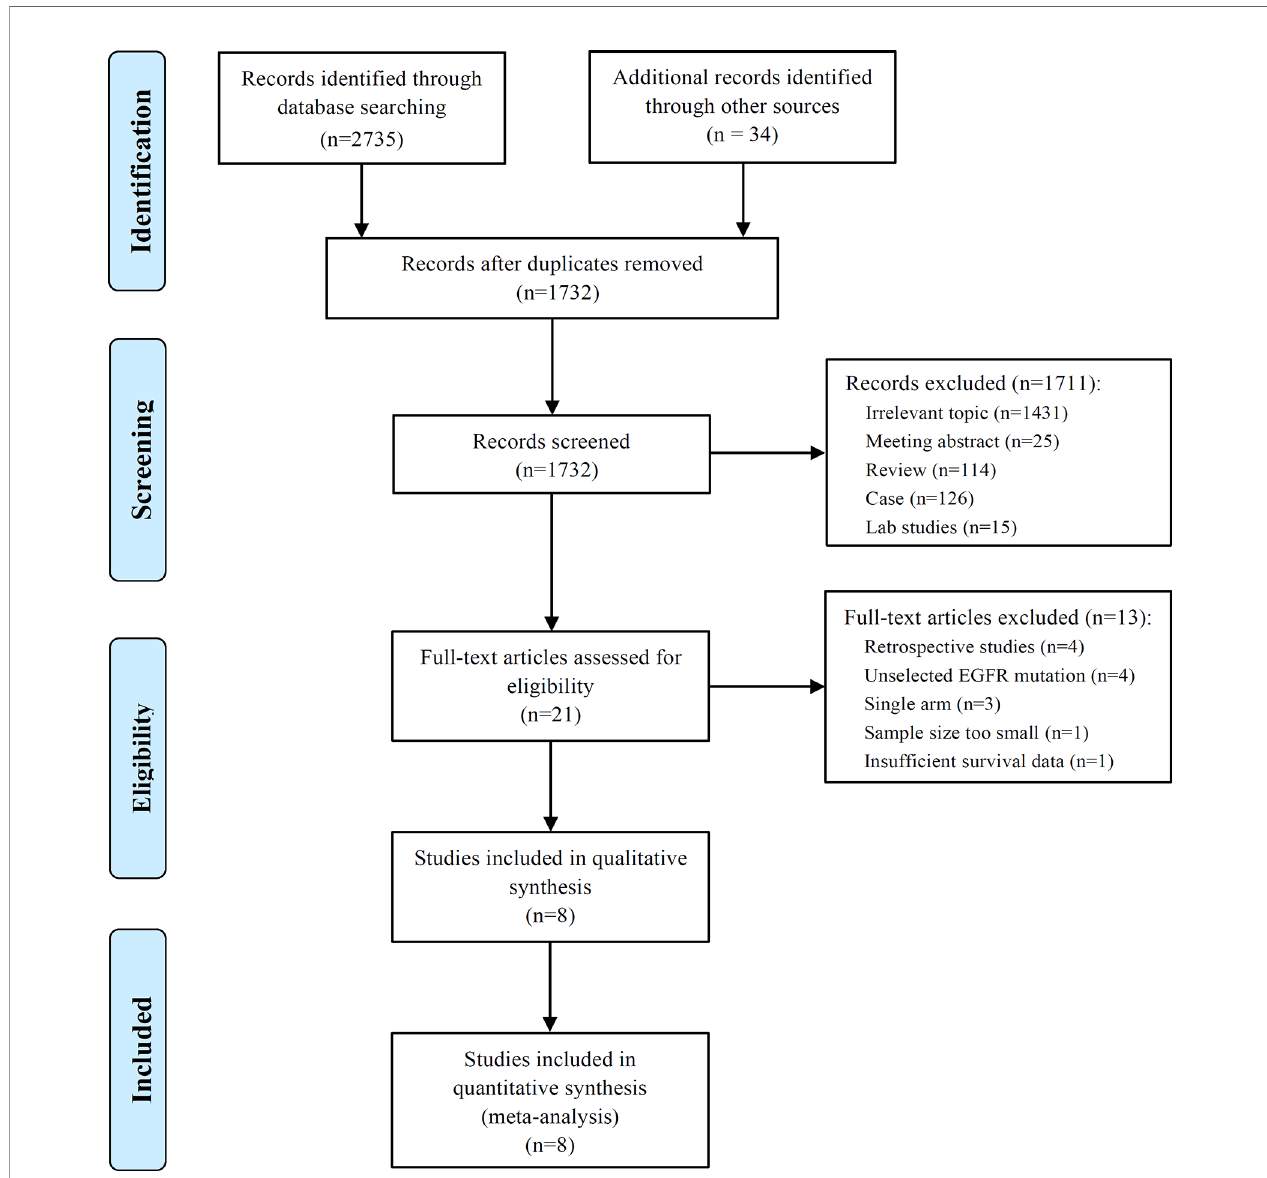
FIGURE 1 | The fl ow diagram of studies